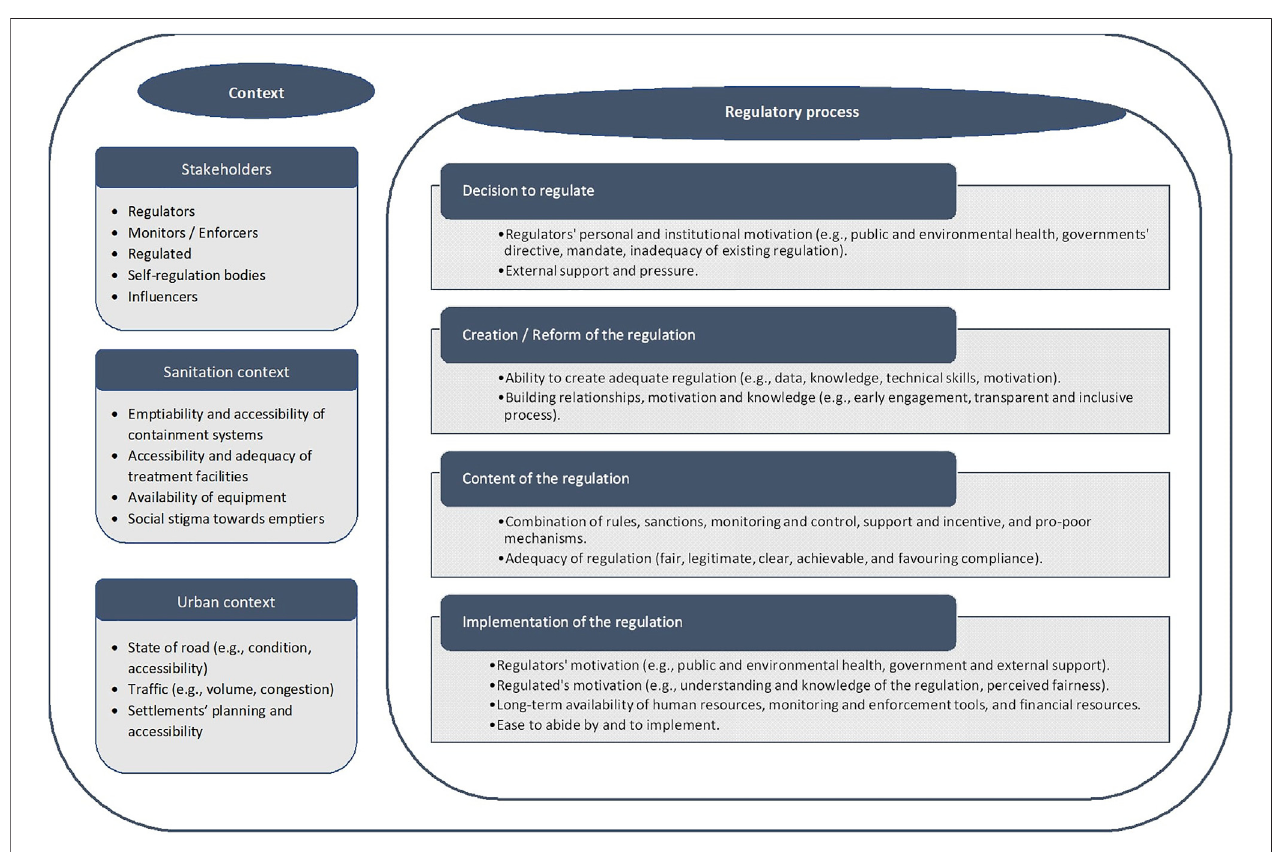
FIGURE 2 | Elements in fl uencing the regulation of emptying and transport services for fecal sludge.